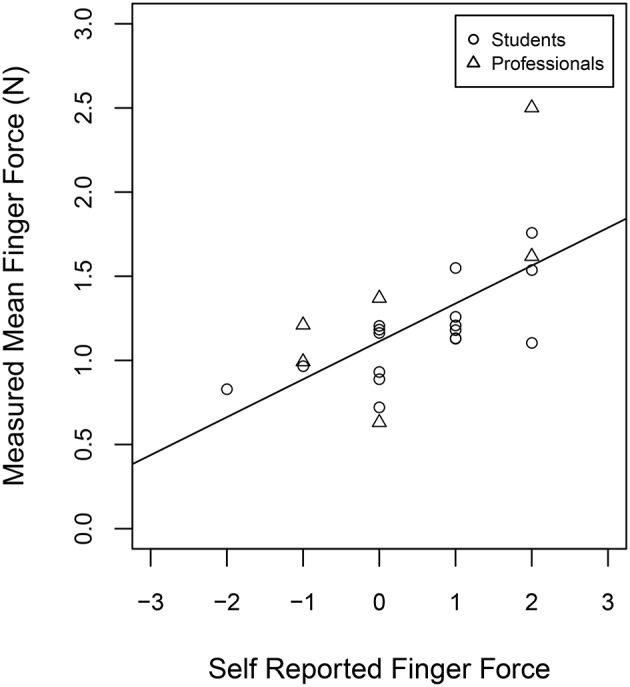
Self-estimation of finger forces (from −3 to +3) and measured finger forces Fmean for the expressive performances of the Weber Concerto.